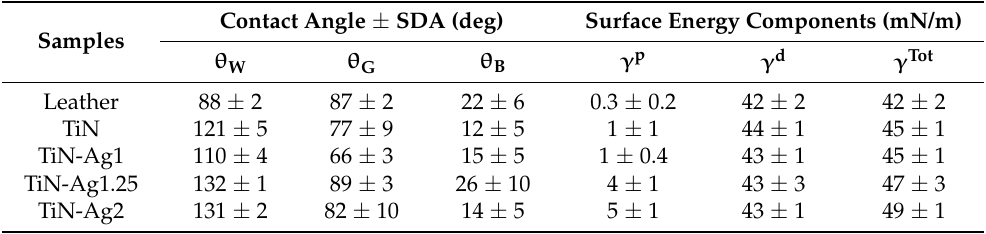
Figure 2. The water contact angle of the several samples, represented as a mean ± standard deviation. Table 2. Water ( θ W ), glycerol ( θ G ) and αααα -bromonaphthalene ( θ B ) contact angles, surface energy components: polar component ( γ p ), dispersive component ( γ d ) and total surface energy component ( γ Tot ) of the different